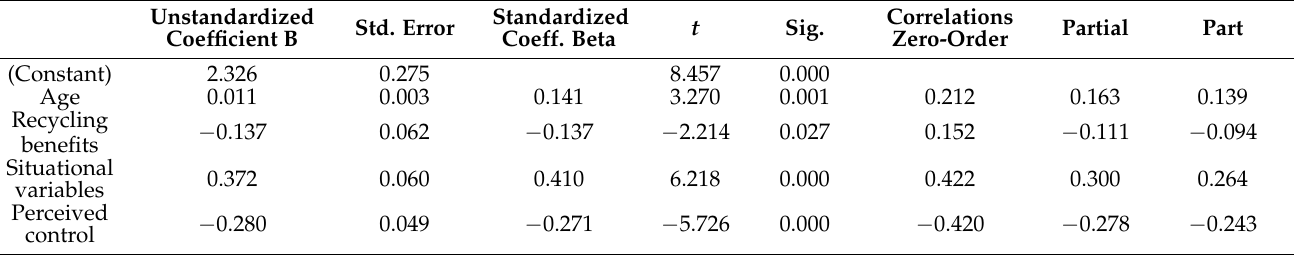
Table 13. Calculated coefficients and correlations